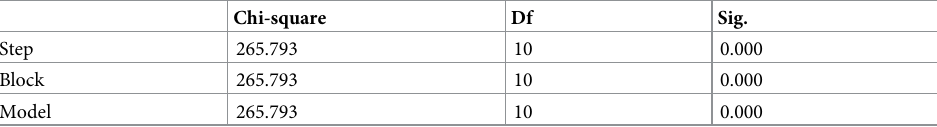
Table 6. Omnibus tests of model